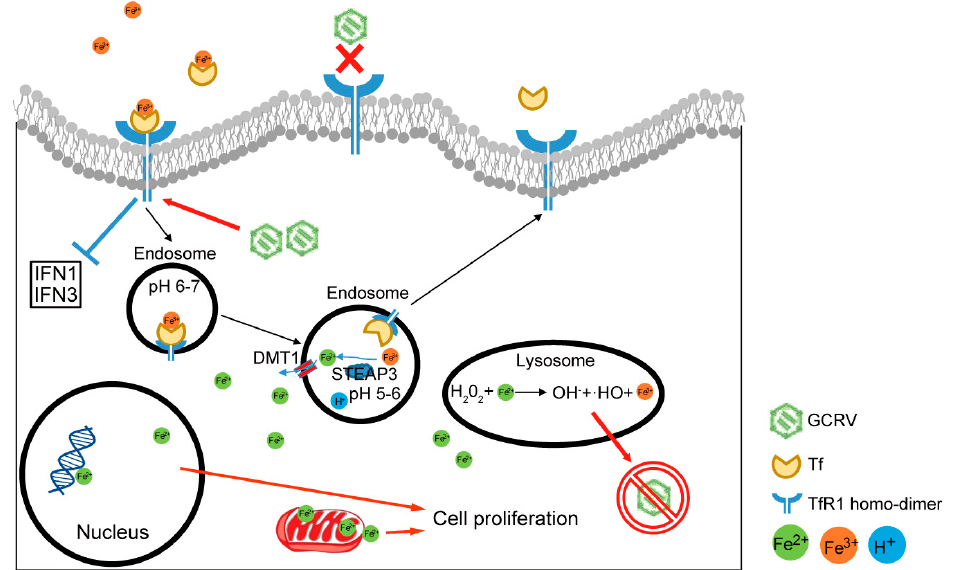
Figure 10. Schematic representation of CiTfR1 inhibiting virus replication. Upon GCRV infection, CiTfR1 is unable to facilitate GCRV cell entry (red X), but imports more iron into cells to enhance intracellular oxidative stress and promote cell proliferation, aiming at suppressing GCRV infection (red arrows and forbidden symbol). Meanwhile, CiTfR1 has a weak inhibitory e ff ect on the expression of CiIFN1 and CiIFN3 (blue block